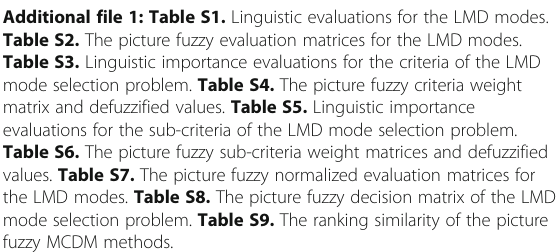
Table S3. Linguistic importance evaluations for the criteria of the LMD mode selection problem. Table S4. The picture fuzzy criteria weight matrix and defuzzified values. Table S5. Linguistic importance evaluations for the sub-criteria of the LMD mode selection problem. Table S6. The picture fuzzy sub-criteria weight matrices and defuzzified values. Table S7. The picture fuzzy normalized evaluation matrices for the LMD modes. Table S8. The picture fuzzy decision matrix of the LMD mode selection problem. Table S9. The ranking similarity of the picture fuzzy MCDM